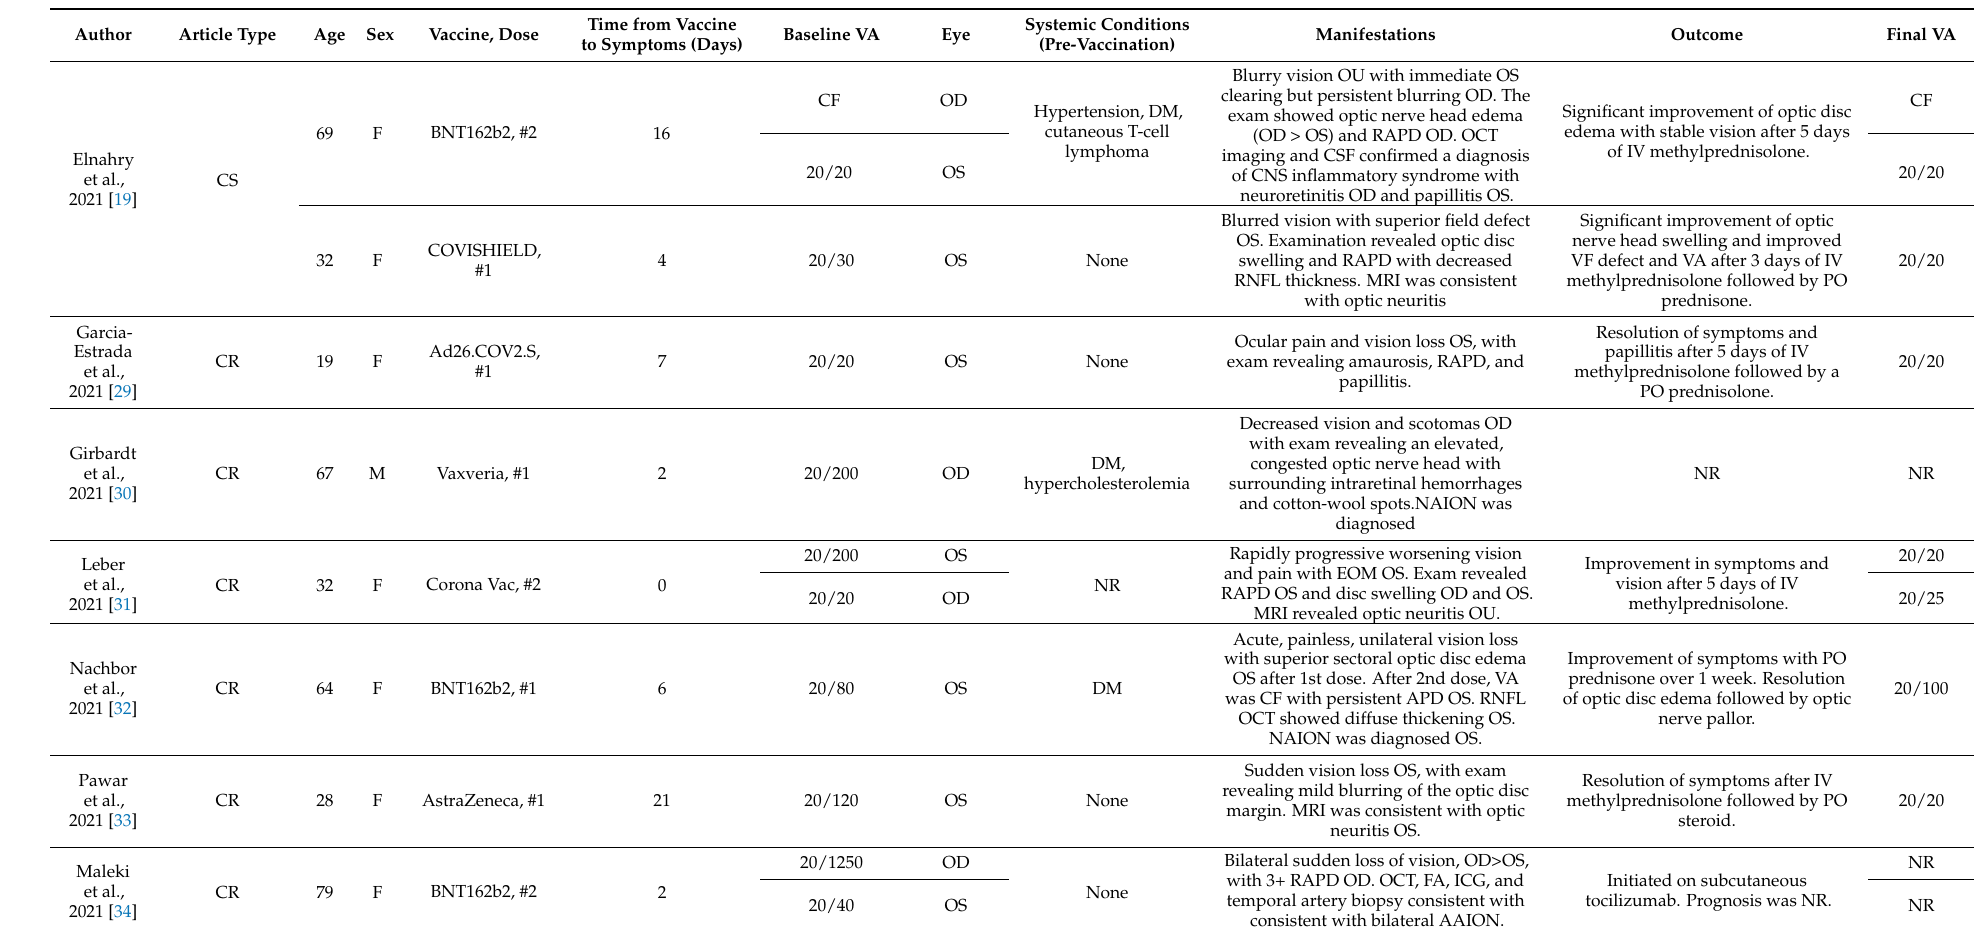
Table 1. Summary of cases of optic neuropathy following COVID-19